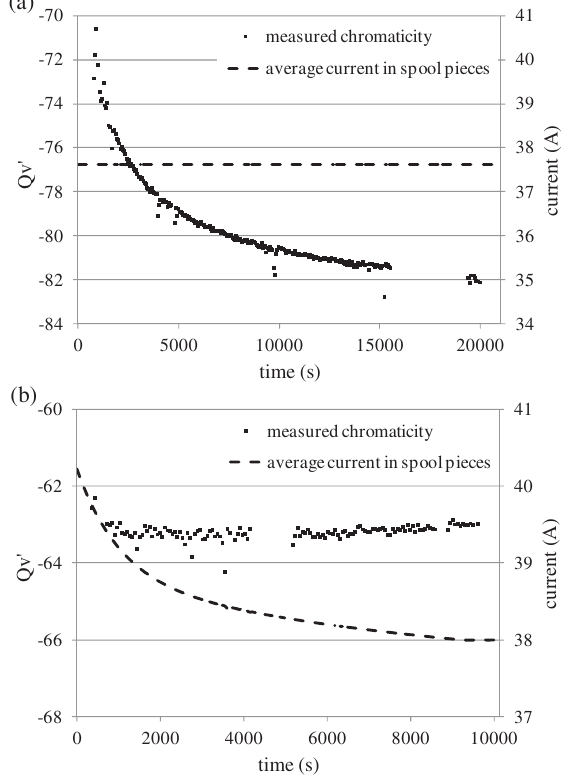
FIG. 8. Chromaticity behavior and current in the spool pieces during the injection plateau before (a) and after (b) the imple- mentation of the dynamic decay correction. Data shown in (a) was measured on 21 = 02 = 2011 and the data shown in (b) was taken on 02 = 05 = 2011 .